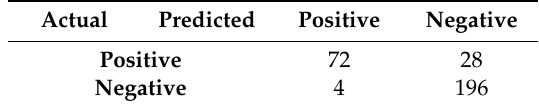
Table 2. Confusion matrix of the proposed model ( n = 300).